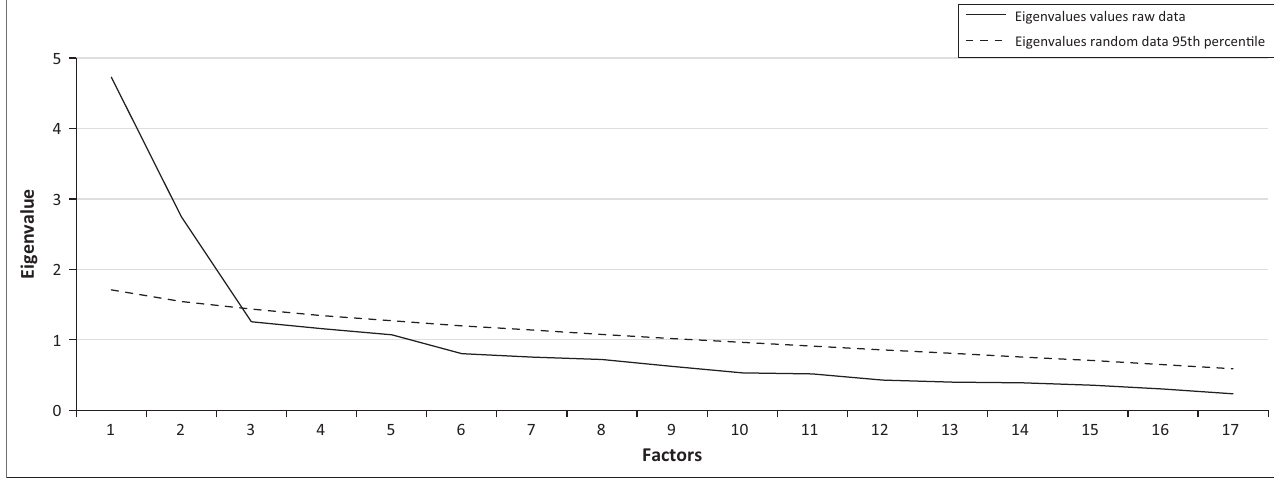
FIGURE 1: Scree plot and Horn’s parallel test for number of significant factors to be retained on the Test Attitude Survey – an adapted version of the measure. TABLE 1: Total variance of extracted factors explained for the Test Attitude Survey – an adapted version of the measure. Factor Cognitive ability tests: Initial eigenvalues Personality test: Initial